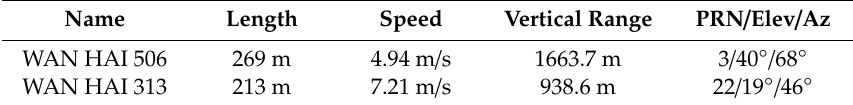
Table 3. Automatic identification system (AIS) information and the selected GPS satellites.